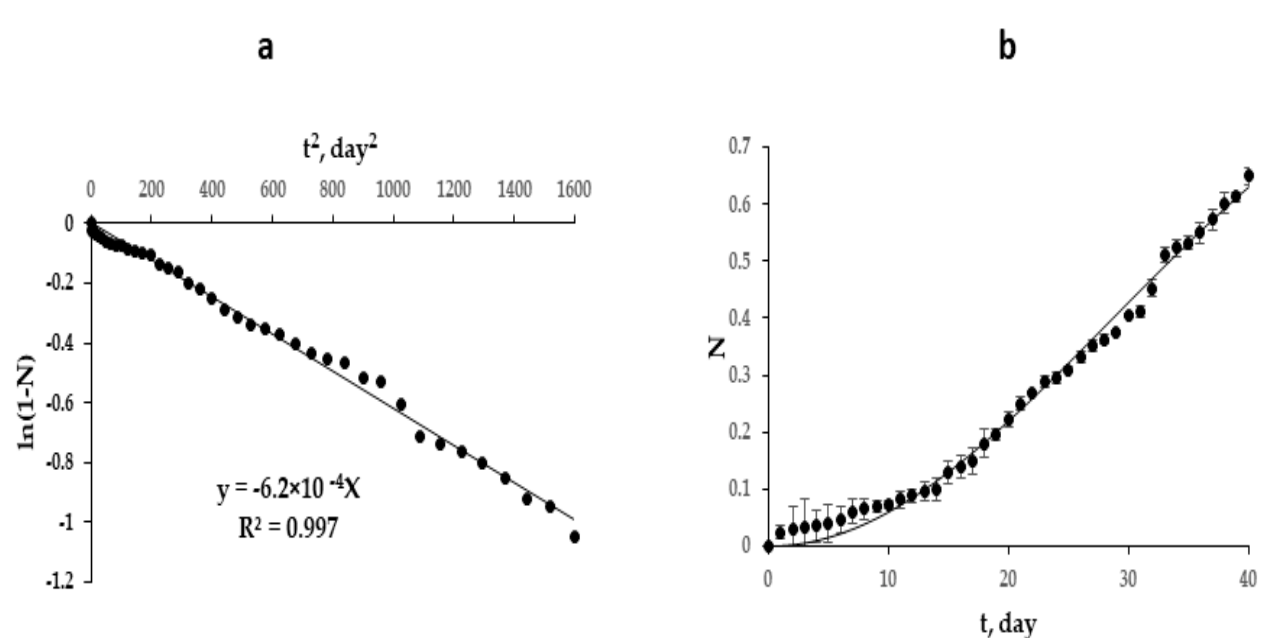
Figure 8. Kinetics of urea release: ( a ) linear dependence in the coordinates “ln(1 − N ) vs. t 2 ”; ( b ) theoretical (continuous line) and experimental (points) kinetic curves of nitrogen accumulation in water.